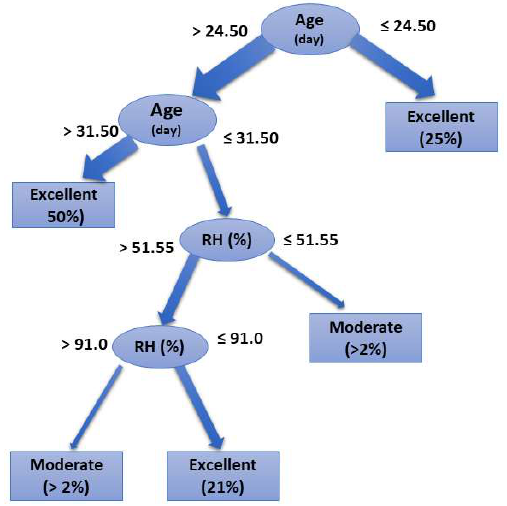
Figure 3. The random-tree operator’s result applied to the final rearing condition dataset, indicating that broiler age and relative humidity are determinants for selecting the rearing condition’s suita- bility.